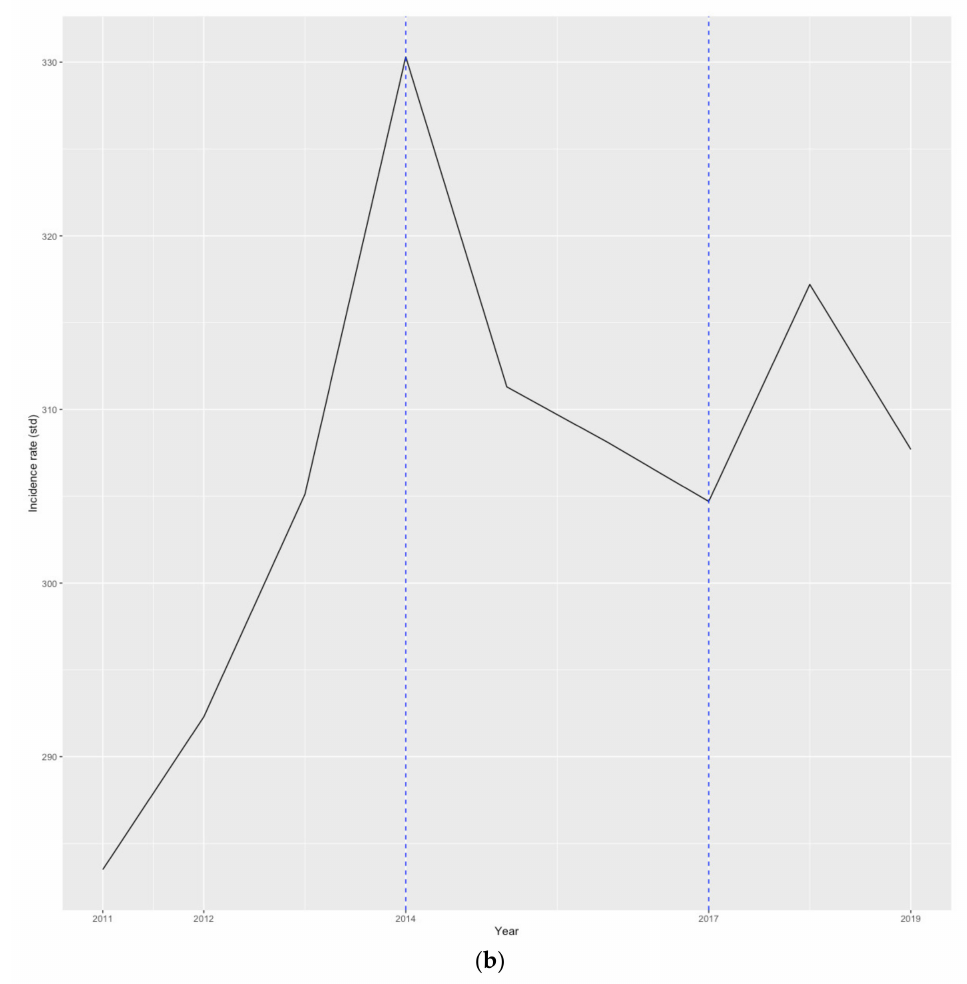
Figure 4. Trends in age-standardized cancer incidence and mortality rates in Romania (2010–2019) (panel a ); join-points in cancer incidence rate (panel b ). Source of data: Romanian Ministry of Health (2021) [32]. Chart in panel ( a ) is produced in Datawrapper. Chart in panel ( b ) is produced with the “ggplot” function in R software; join-point regression analysis is performed with the “segmented” package within R